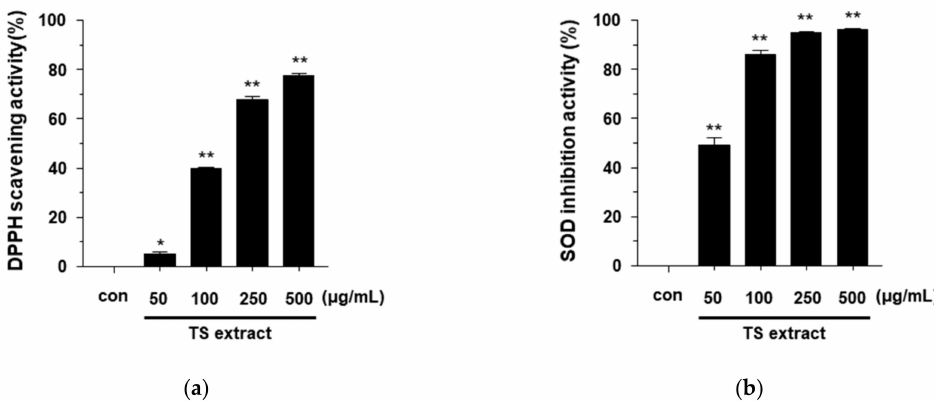
Figure 2. Antioxidant activity of TS extract. ( a ) DPPH scavenging activity of TS extract (50, 100, 250, and 500 µ g / mL) was measured by DPPH assay; ( b ) SOD inhibition activity of TS extract (50, 100, 250, and 500 µ g / mL) was determined by SOD assay kit. Ascorbic acid was used as a positive control. Values are expressed as mean ± SD of three independent experiments. * p < 0.05; ** p < 0.001 vs. the